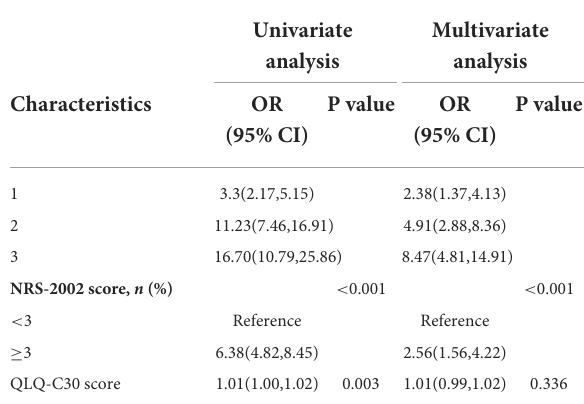
TABLE 3 Univariate and multivariate logistic regression analyses of the risk factors associated with low SMI in the training cohort a